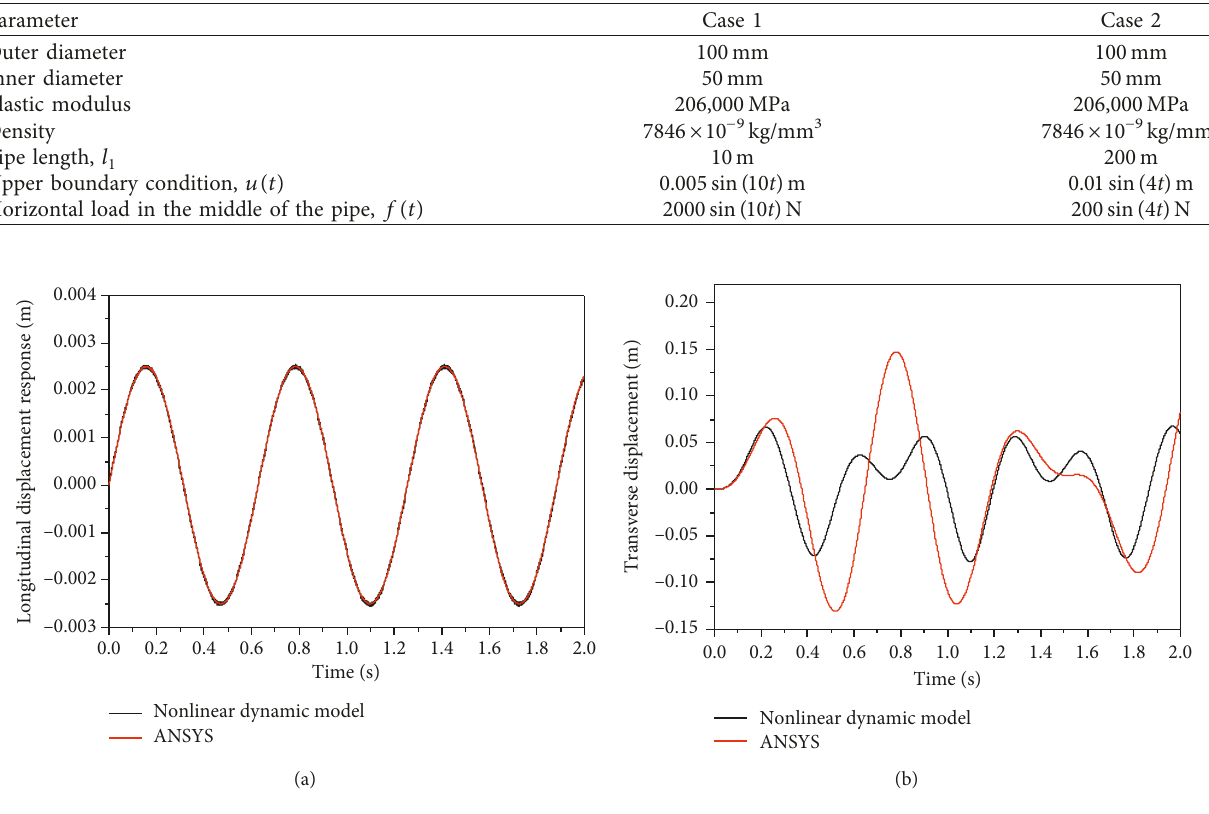
Figure 4: Time history responses of (a) longitudinal and (b) transverse displacements of the middle section of the standpipe in case 1.